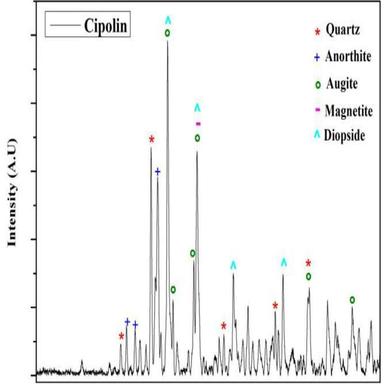
Experimental X-ray powder diffraction profile of CIP at room temperature.